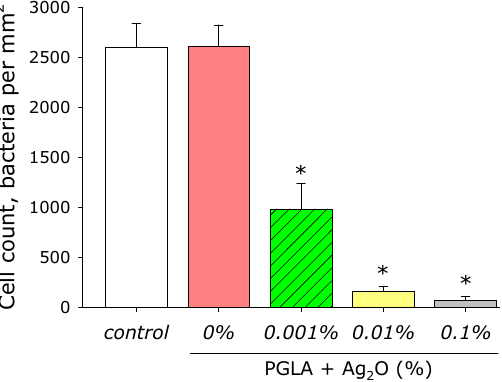
Figure 10. Influence of composite PLGA/Ag 2 O NPs on the E. coli growth (bacteriostatic effect). *— p < 0.05 versus control. Data are presented as mean ± SE.